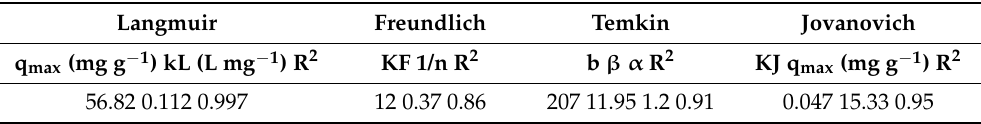
Table 4. Isotherm model parameters and correlation co-efficient (R 2 ) for CIPRO adsorption on Fe 3 O 4 /C. Langmuir